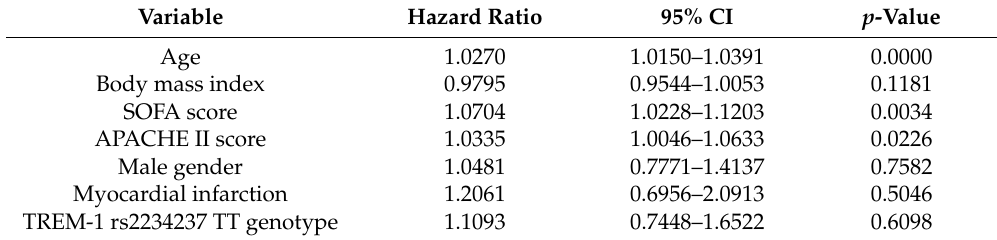
Table 2. Cox regression analysis (90 days) with regard to TREM-1 rs2234237 genotypes. Variable Hazard Ratio 95% CI p -Value